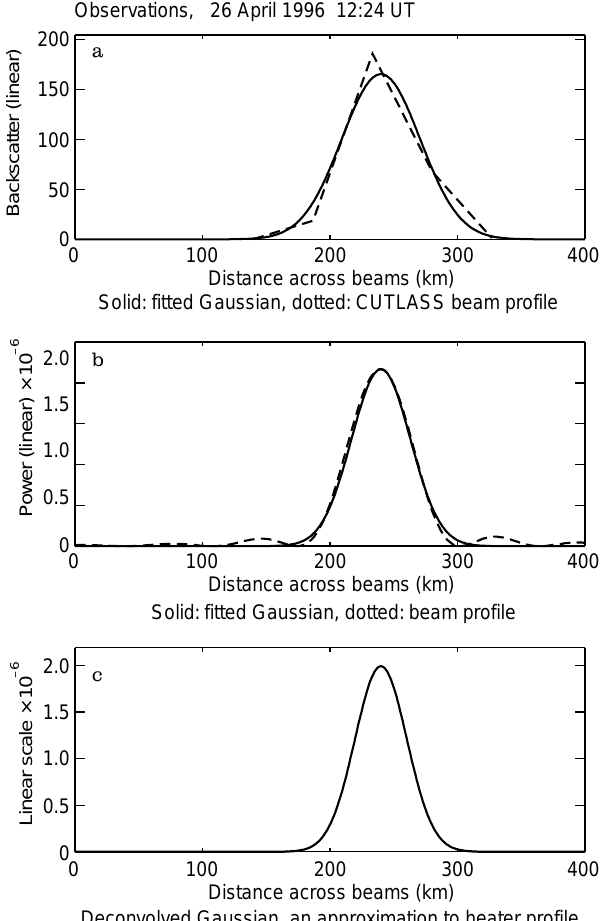
Fig. 4. Observations for 1224UT on 26 April 1996. a The dotted line represents backscatter power from CUTLASS Finland across beams 3–7 at a range gate over Tromsø. The solid line is a Gaussian function fitted to the data. b The dotted line represents a modelled beam profile for the CUTLASS antenna system. The solid line is a Gaussian fitted to the beam profile. c An analytical profile produced by deconvolving the Gaussian fitted to the beam profile from the curve fitted to the backscatter data